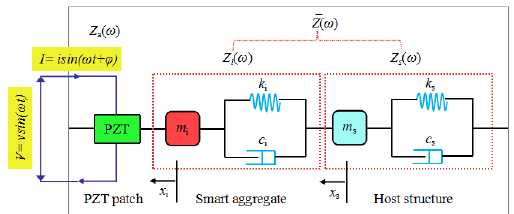
Figure 2. The 2D electro-mechanical impedance model of Lead Zirconate Titanate (PZT)-SA-host structure system.